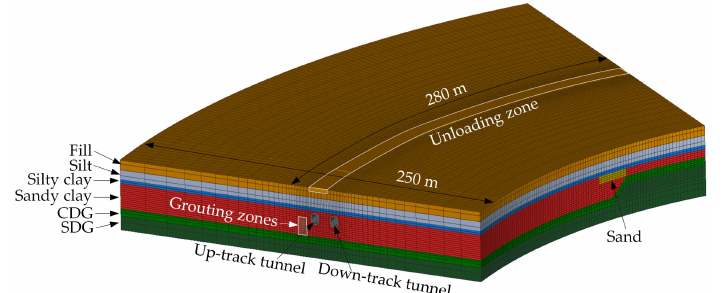
Figure 4. Finite element model.